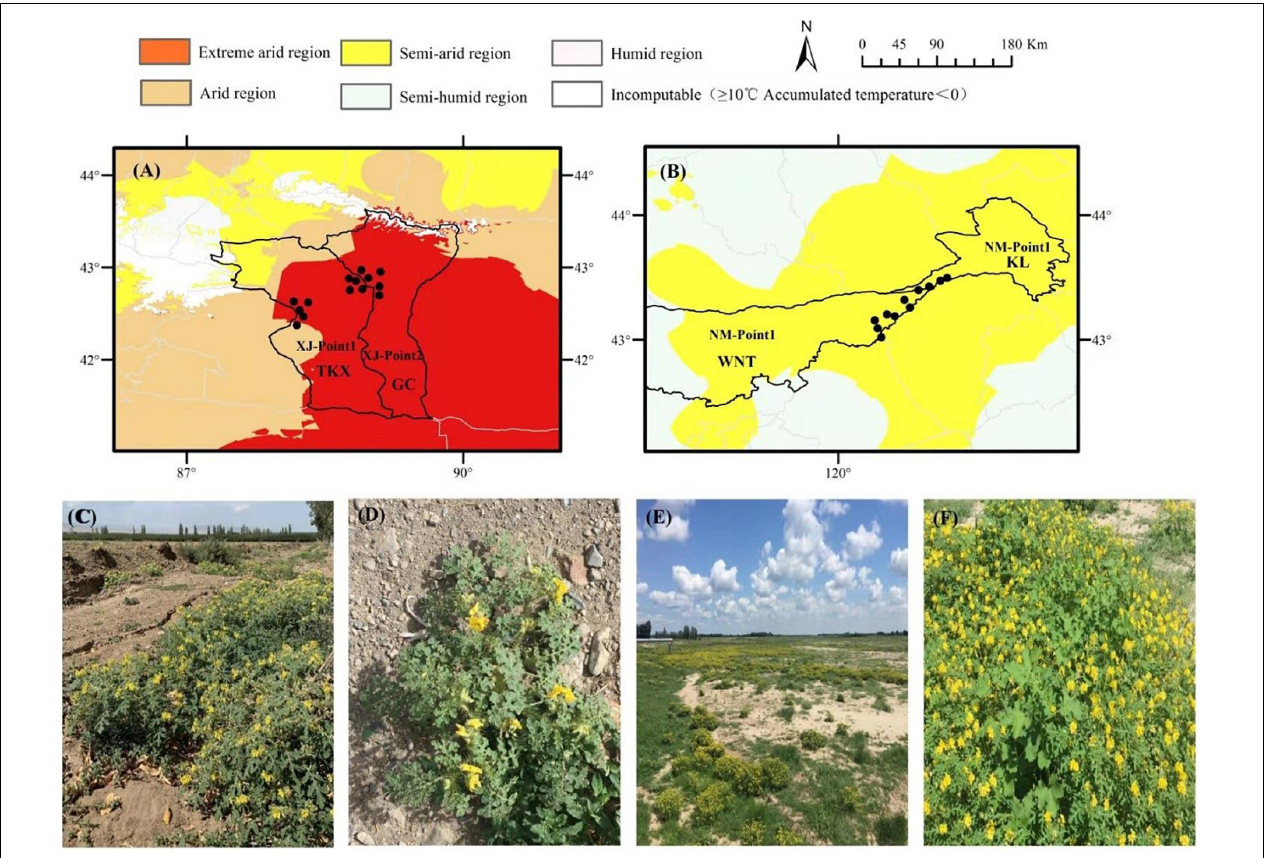
FIGURE 1 | Locations of seed collection sites for Solanum rostratum used in this study. The collection sites of Xinjiang were located in an extremely arid climate region (A) , mainly distributed in Tuokexun County ( A , XJ-Point1, abbreviated as TKX) and Gaochang district ( A , XJ-Point2, abbreviated as GC) of Turpan city. The distribution habitat included farmland fields (C) and roadside communities (D) . The collection sites in Inner Mongolia were in a semi-arid climate region (B) , mainly distributed in Ongniud Banner ( B , NM-Point1, abbreviated as WNT) and Kailu County ( B , NM-Point2, abbreviated as KL). The distribution habitat included river courses in the dry season (E) and grassland communities (F)